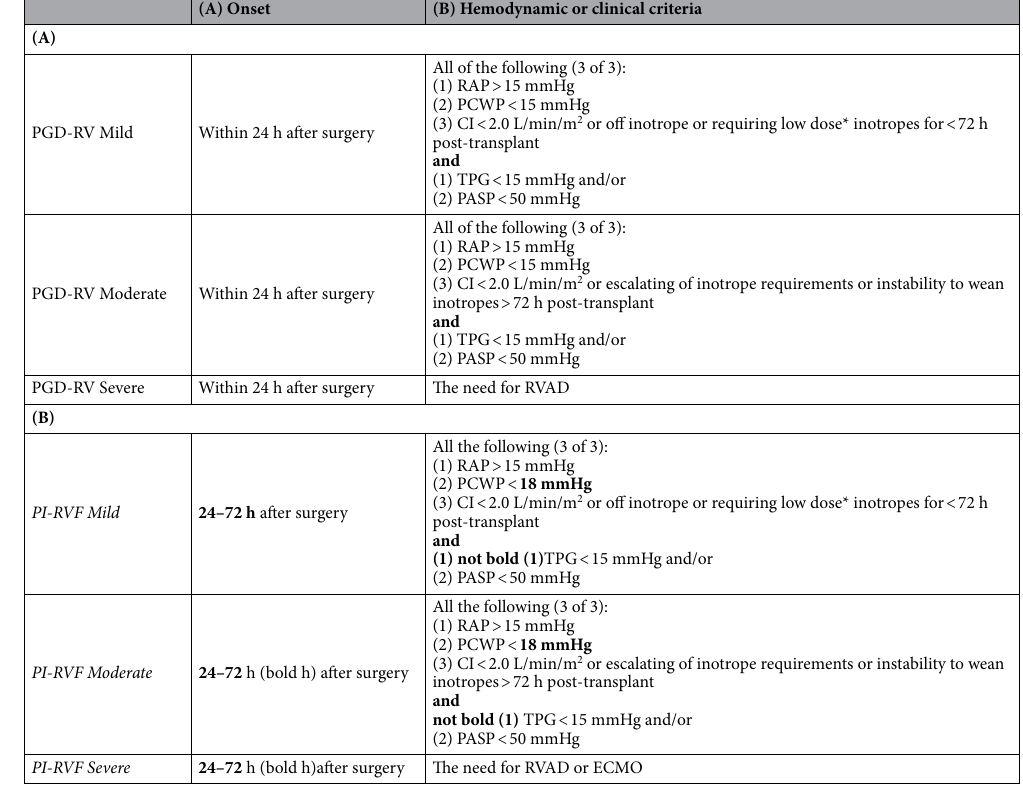
Table 1. (A) Current modified diagnostic criteria of primary graft dysfunction -right ventricle (PGD-RV) 14 . (B) Proposed diagnostic criteria of primary isolated right ventricular failure (PI-RVF). CI cardiac index, PASP pulmonary systolic pressure, PCWP pulmonary capillary wedge pressure, PGD-RV primary graft dysfunction- right ventricle, RVAD right ventricular assisted device, RAP right atrial pressure, TPG transpulmonary gradient. *Low dose was defined by the following criteria: (1) single inotrope infusion: dobutamine < 7.5 µg (mcg)/kilogram (kg)/minute (min) or milrinone < 0.5 mcg/kg/min or epinephrine < 0.02 mcg/kg/min, or (2) two inotropic infusion: dobutamine < 3 mcg/kg/min or milrinone < 0.25 mcg/kg/min or epinephrine < 0.01 mcg/kg/min. 14